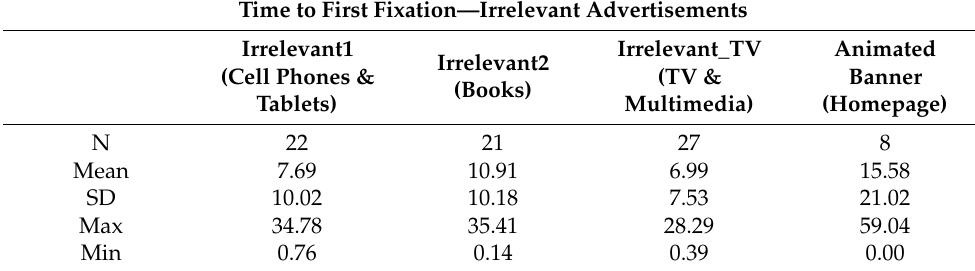
Table 5. Time to first fixation of irrelevant